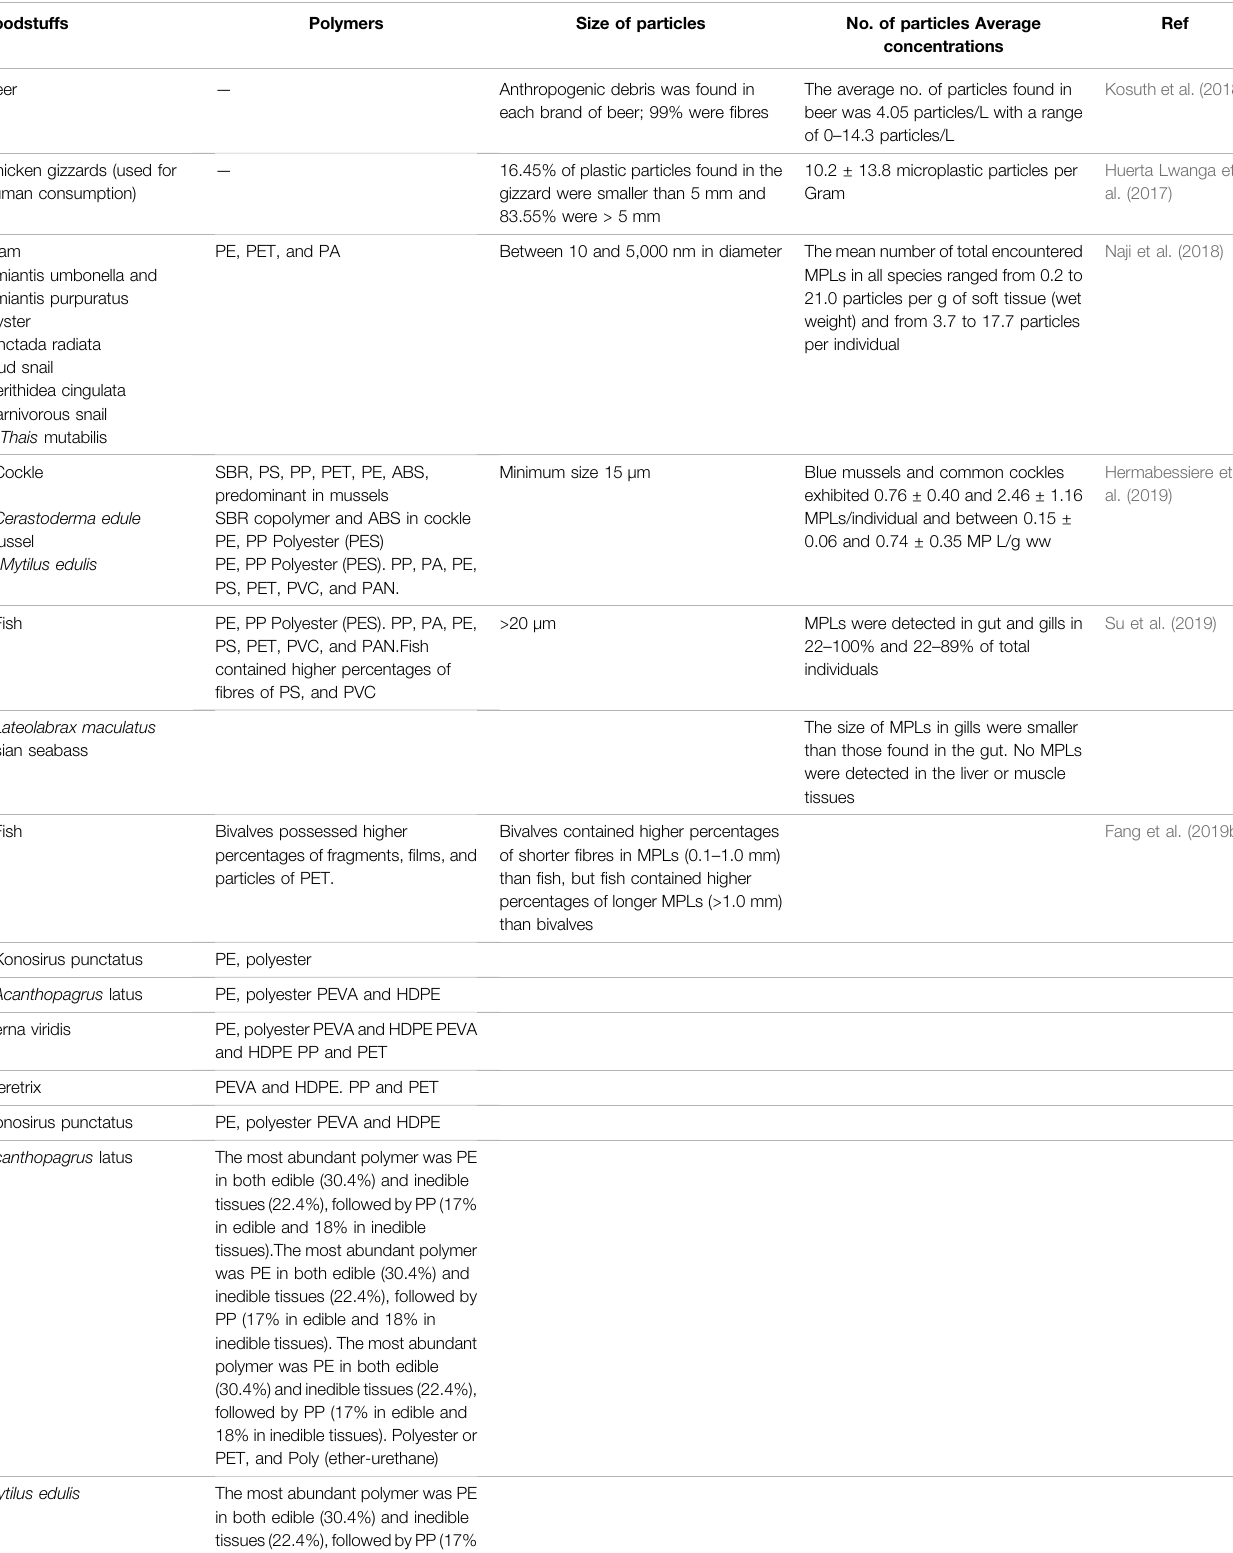
TABLE 1 | Summary of studies assessing MNPLs in